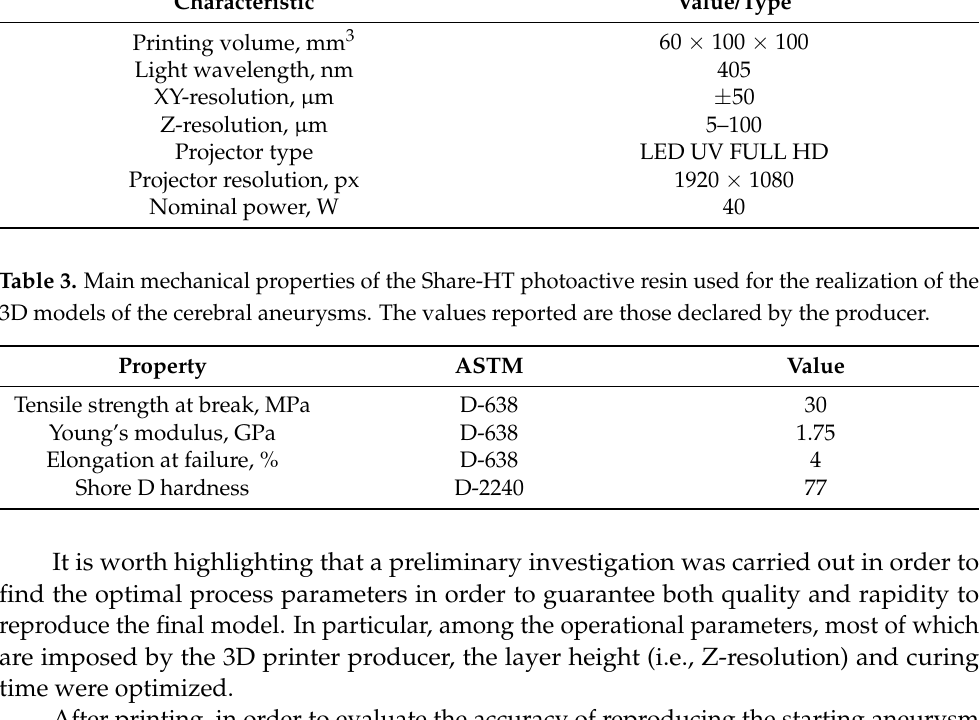
Table 2. Main characteristics of the DLP SHAREBOT Voyager 2 3D printer adopted for the realization of the 3D models of the cerebral aneurysms.